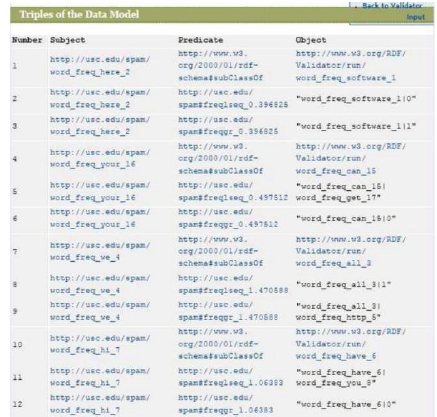
Table 5: Precision and recall of 400 user datasets.